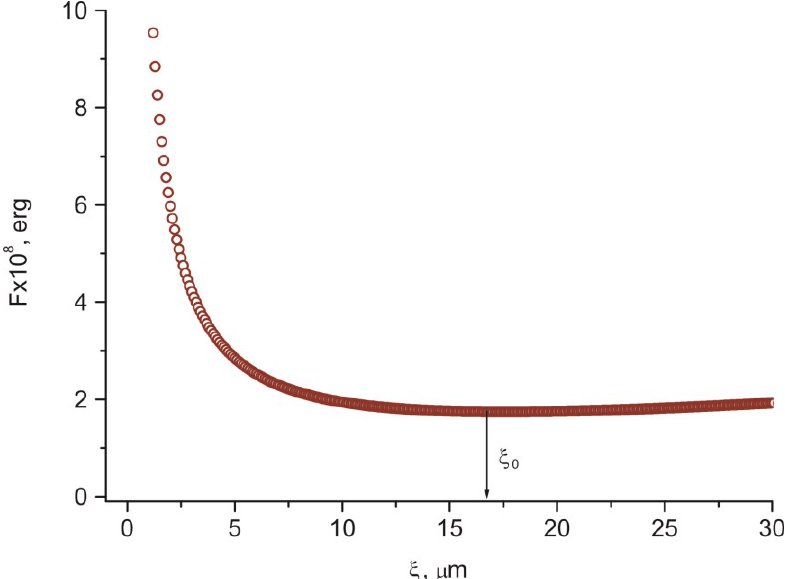
Figure 10. Dependence of free energy F on distance ξ from the PC surface. The arrow indicates equilibrium distance ξ that corresponds to the free energy minimum at the 0 transition of the LC director field distribution from the radial configuration to uniform alignment in the